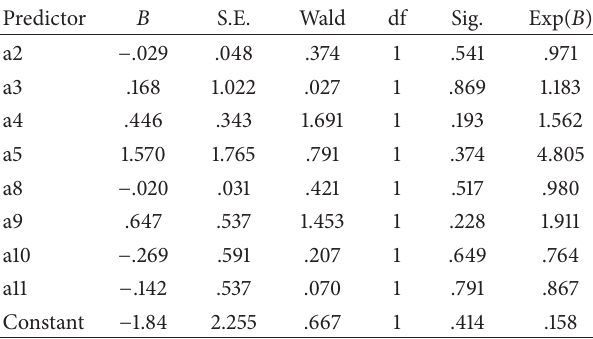
Table 6: Logistic regression for willingness to grow D. steriscus in Chipadze, Aerodrome high, and